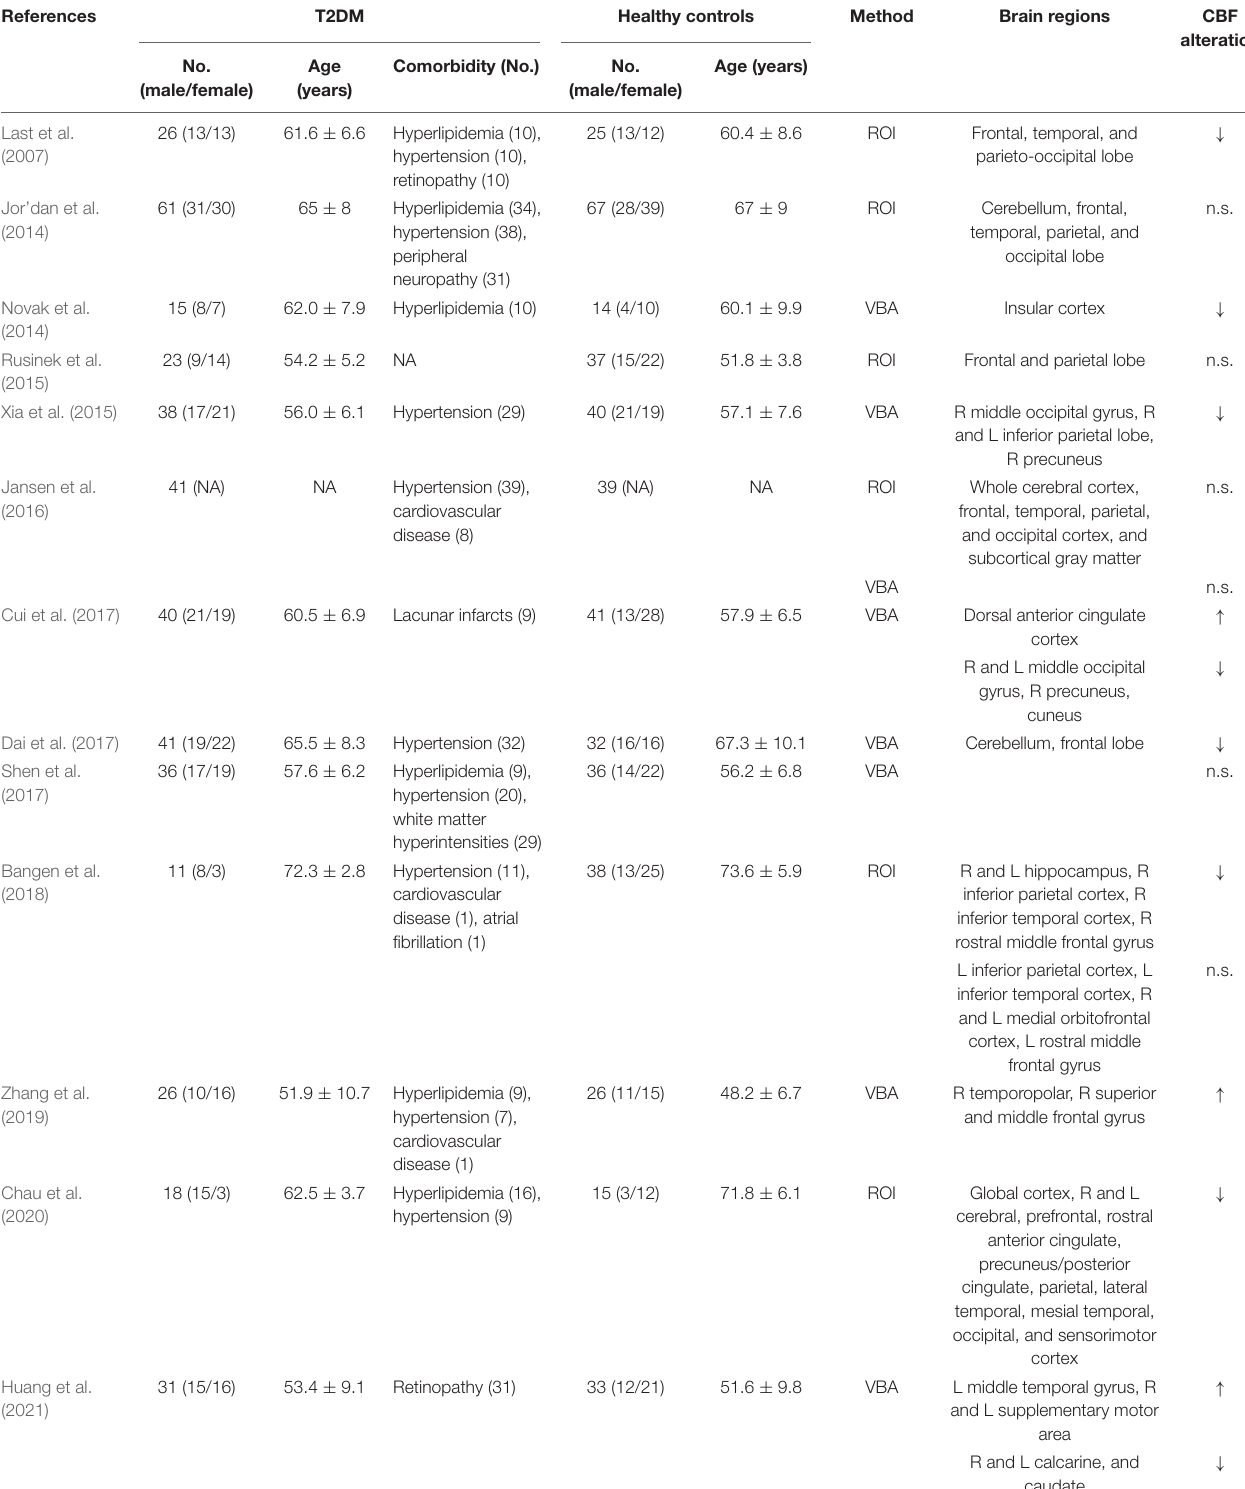
TABLE 1 | Arterial spin labeling studies investigating cerebral blood flow alterations in patients with T2DM relative to healthy